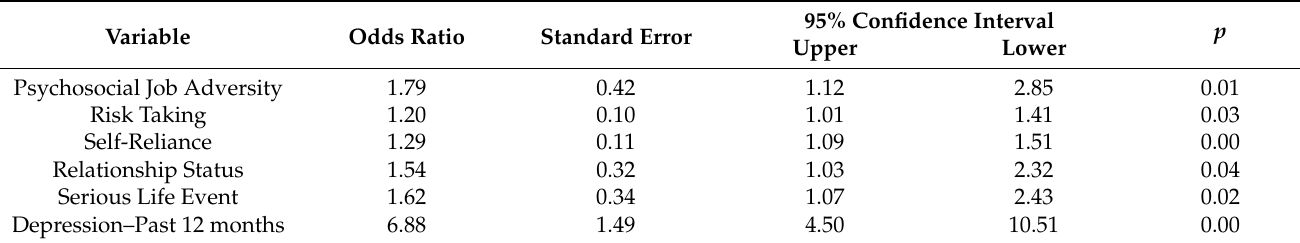
Table 3. Multivariate Logistic Regression Assessing Associations between Suicidal Ideation, Mas- culinity Domains of Self-Reliance, Risk Taking and Psychosocial Job